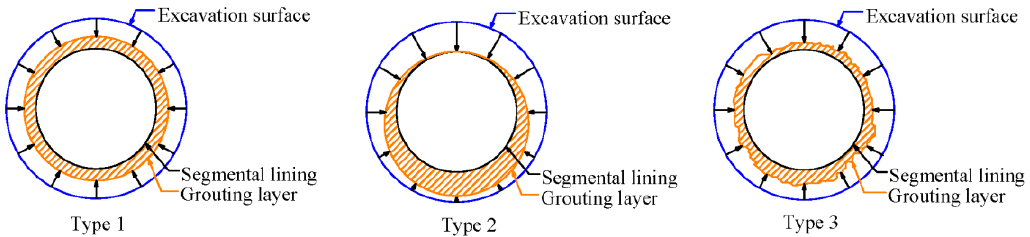
Figure 3. Displacement convergence patterns for different grouting-layer distributions.